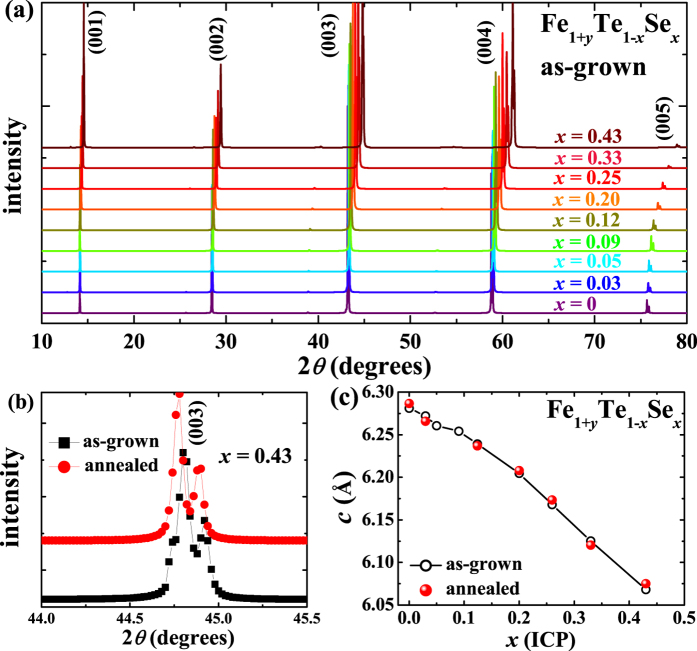
(a) Single crystal X-ray diffraction patterns of the as-grown Fe1+yTe1−xSex (0 ≤ x ≤ 0.43) single crystals. (b) Comparison of the (003) peaks for the as-grown and O2-annealed Fe1+yTe0.57Se0.43. (c) Lattice constant c for Fe1+yTe1−xSex before and after annealing.